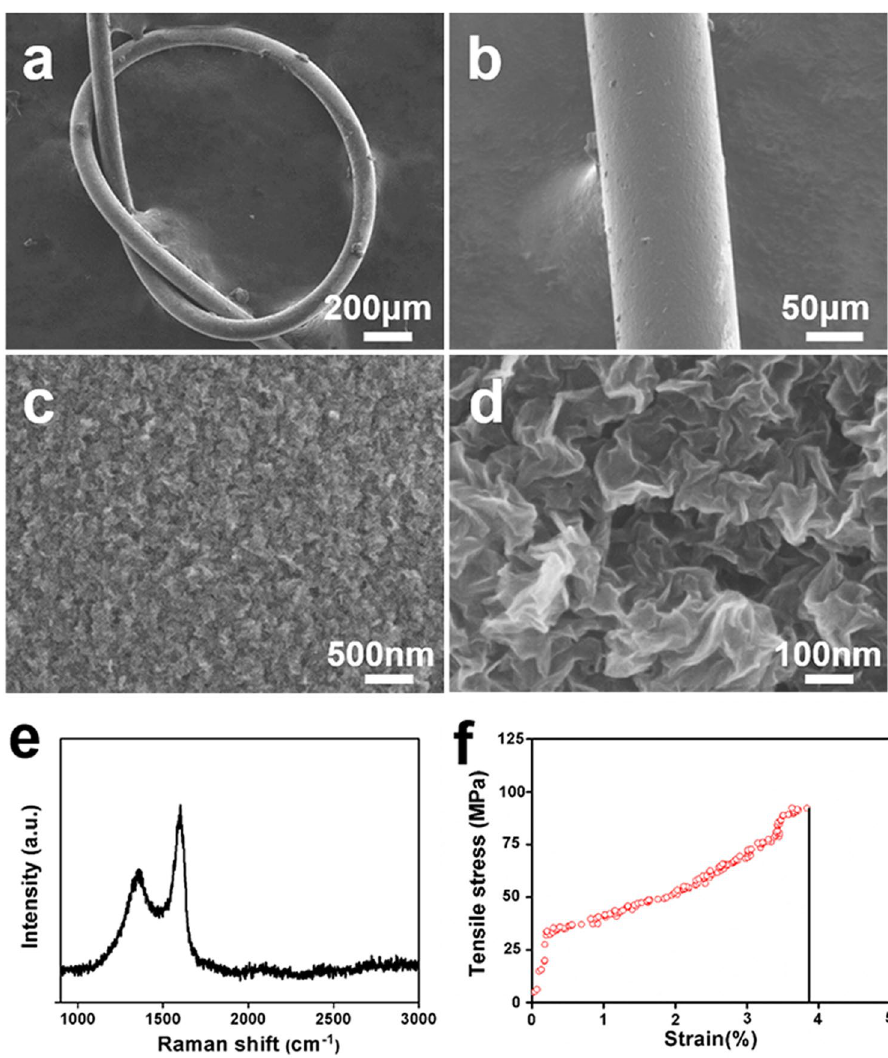
Figure 1. Characterization of nanostructured rGO microfiber. ( a ) SEM image of a knotted nanostructured rGO microfiber, ( b ) SEM image of a straight nanostructured rGO microfiber, and ( c ) ( d ) high-resolution SEM image of the surface morphology of the nanostructured rGO microfiber. ( e ) Raman spectrum of a nanostructured rGO microfiber (black curve), ( f ) stress-strain curve of an as-prepared nanostructured rGO microfiber (red